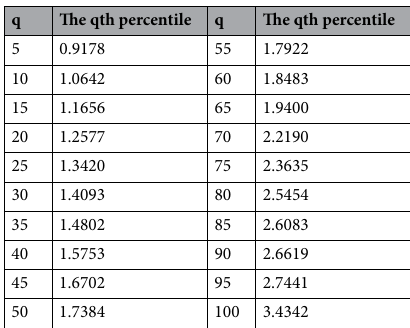
Table 2. The percentiles of JC model distance based on the kernel density estimation method.